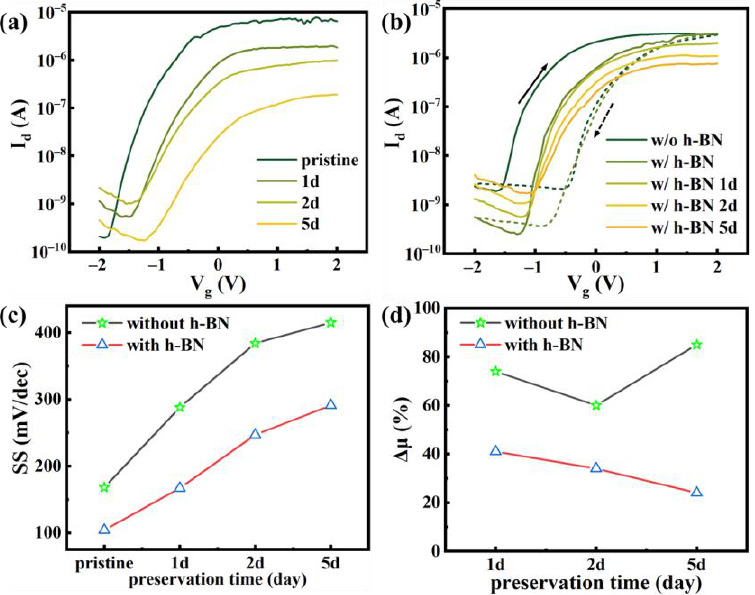
Figure 3. ( a ) Deterioration of electrical properties of 2D InSe FET with preservation time. ( b ) Deterioration of electrical properties after capped with h-BN. The dash lines represent the transfer curves of Vg scanning from 2 to − 2 V. Different arrows indicate the direction of scanning. ( c ) Recession trend of SS for devices with and without h-BN. ( d ) Change curve of device Δμ.